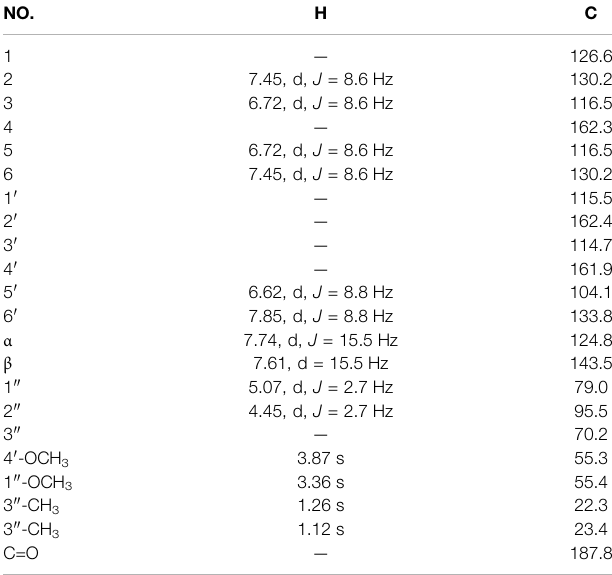
TABLE 1 | 1 H NMR and 13 C NMR data of compound 1 in MeOH (700 MHz). NO.